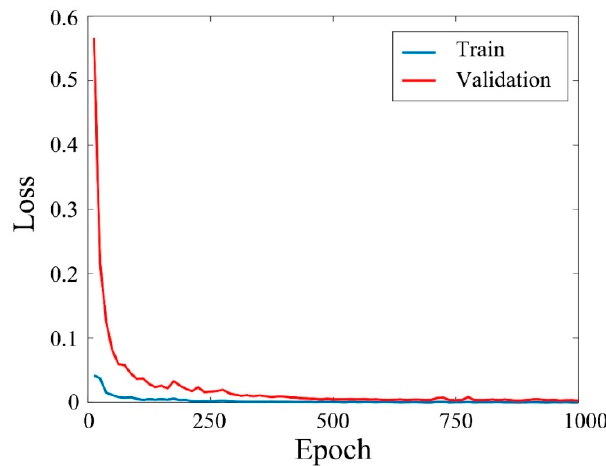
Figure 4. The training and validation convergence curves on Marmousi2 model .